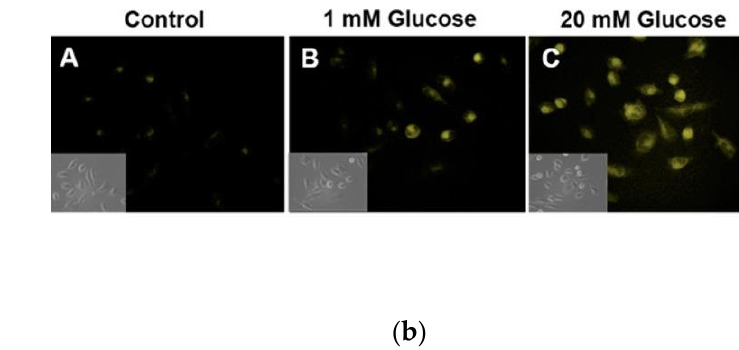
Figure 37. ( a ) The structure of probe BA-Resa; ( b ) Microscopic images of probe RA-Resa in live OSCC cells. Reproduced with permission from [167]. Copyright 2016 American Chemical Society.